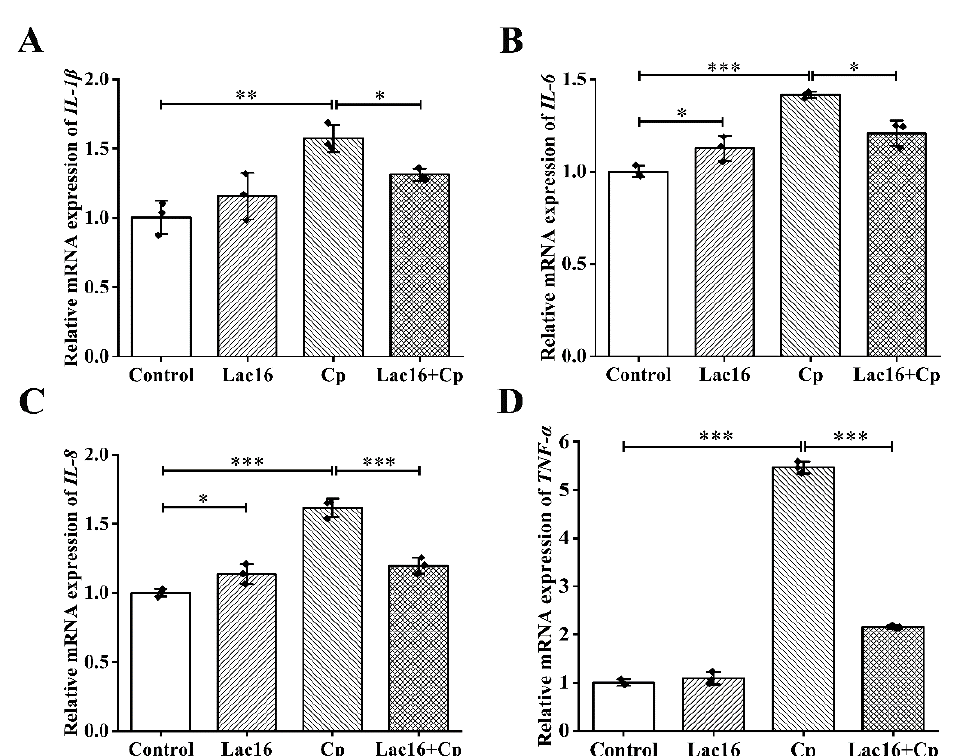
Figure 5. Relative gene expression levels of inflammatory cytokines during C. perfringens infection in IPEC-J2 cells preincubated with L. plantarum Lac16. ( A ) IL-1 β , ( B ) IL-6 , ( C ) IL-8 , ( D ) TNF- α . mRNA expression was standardized to β -actin expression. Data are presented as the means ± SD for n = 3; * p < 0.05, ** p < 0.01, *** p < 0.001 ( t test).